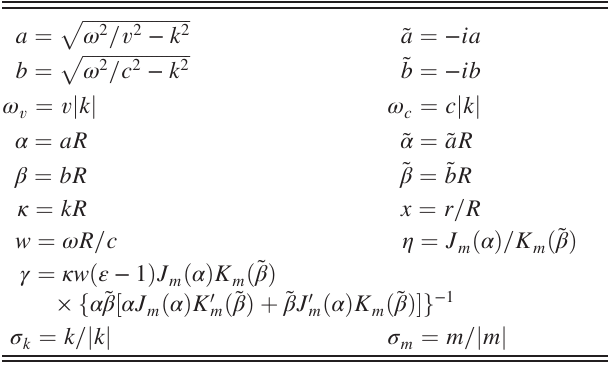
TABLE III. Definitions of the radial constants a and b , as well as the dimensionless quantities appearing in the photon modal fields. The definitions are given in terms of the azimuthal order m , propagation constant k , frequency ω , radial position r , fiber radius R , and the light speed c in vacuum and v ≡ c= fiber,